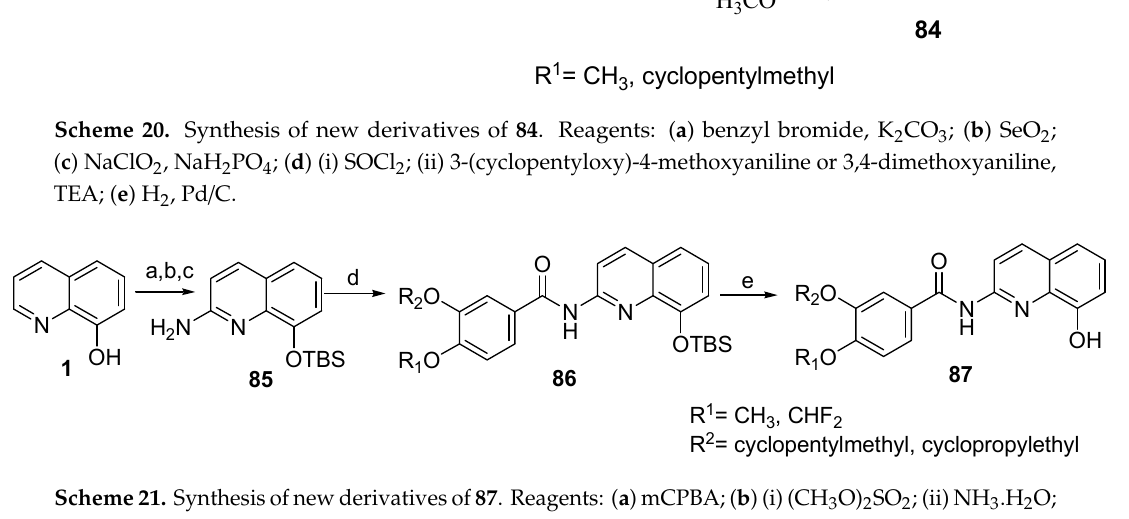
Scheme 21. Synthesis of new derivatives of 87 . Reagents: ( a ) mCPBA; ( b ) (i) (CH 3 O) 2 SO 2 ; (ii) NH 3 .H 2 O; ( c ) TBSCl; ( d ) substituent benzoyl chlorides; ( e ) TBAF.